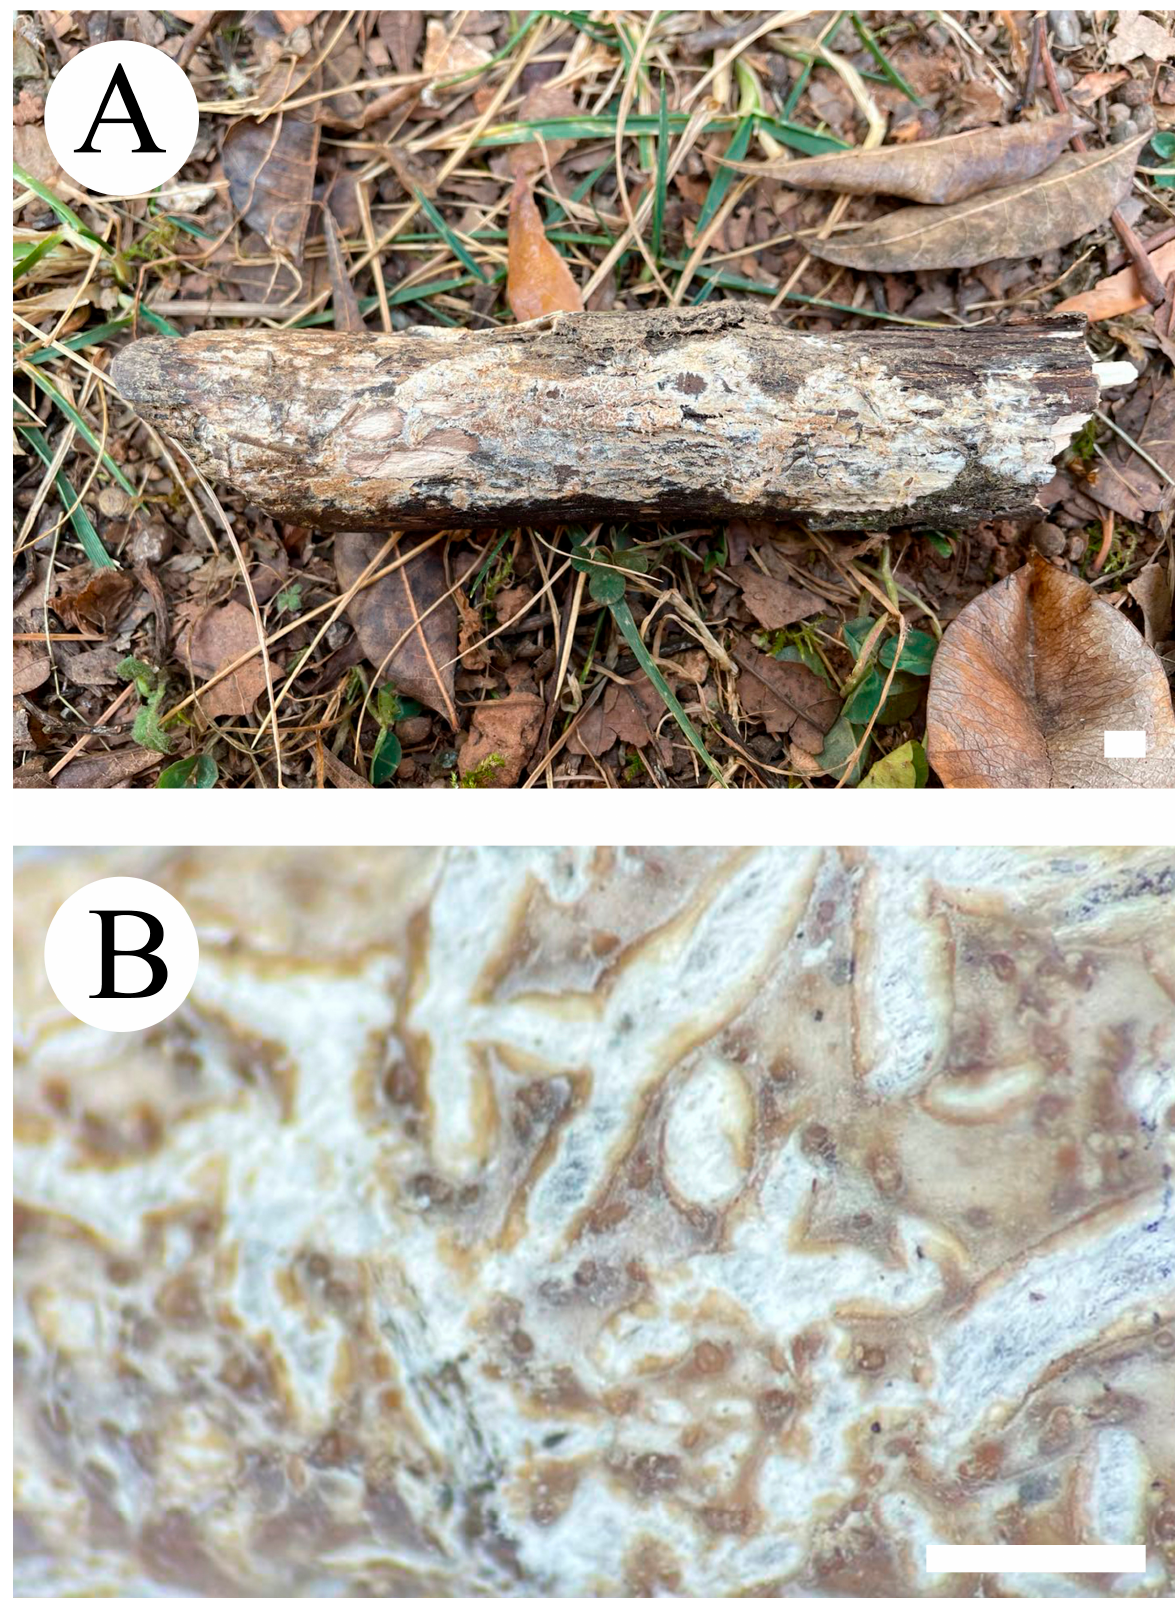
Figure 5. Basidioma of Hydnophlebia fissurata (CLZhao 2900, holotype). Bars: ( A ) = 1 cm, ( B ) = 1 mm.